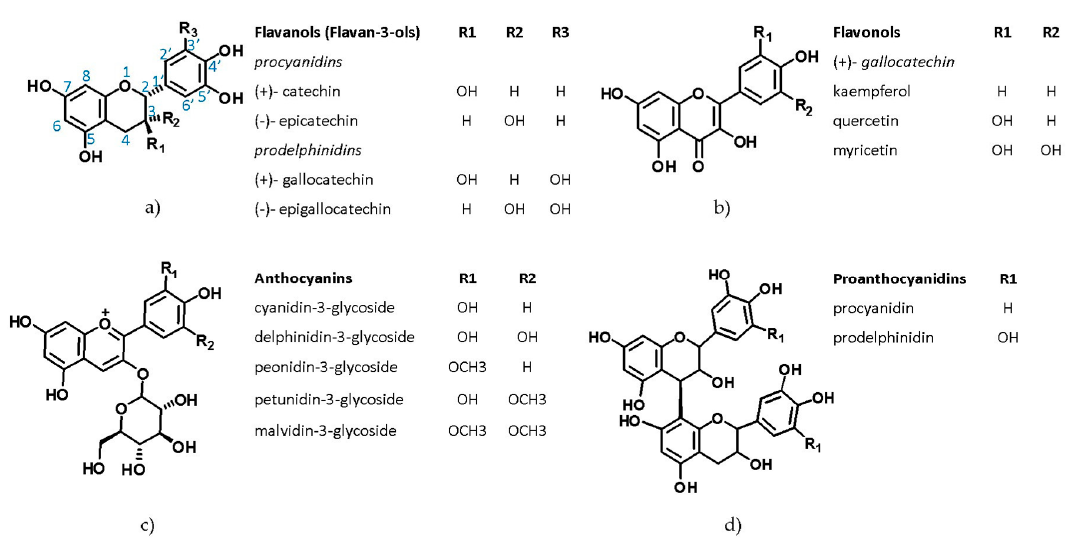
Figure 1. The chemical structures of some groups of polyphenols identified in V. vinifera L. grape pomace. Flavonoids ( a ) flavanols (flavan-3-ols); ( b ) flavonols; ( c ) anthocyanins and Condensed tannins; ( d ) proanthocyanidins.